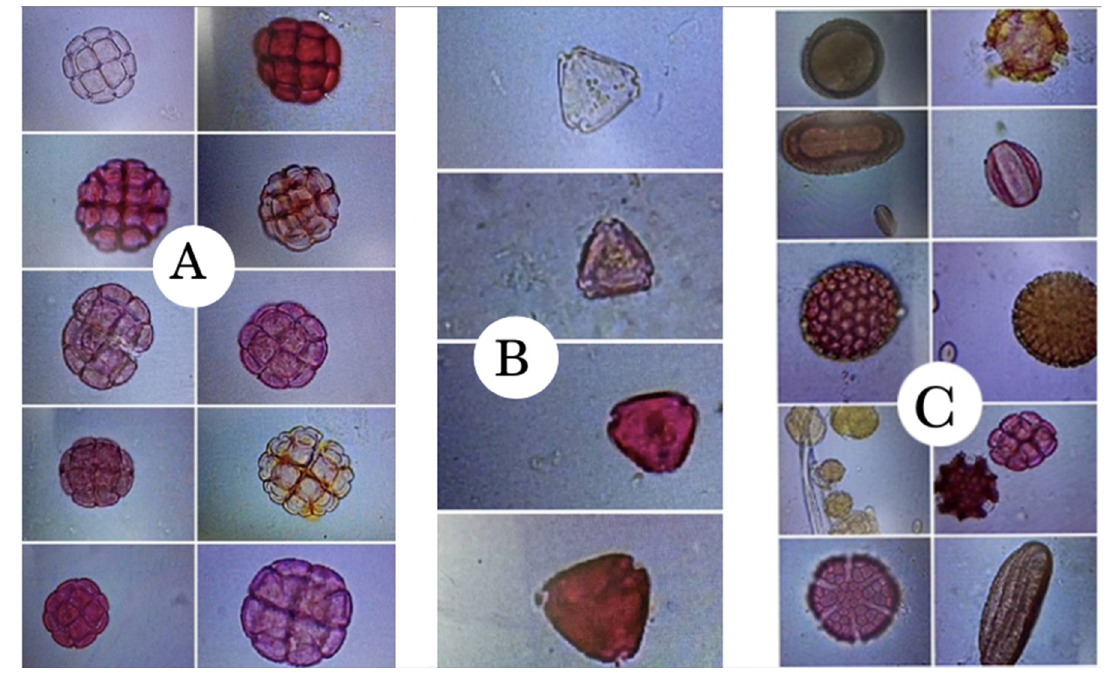
Figure 2. Representative pollens for the floral origins of the studied honey samples. The studied honey samples were of three floral origins: Acacia ( A ), Ziziphus ( B ) and polyfloral ( C ).